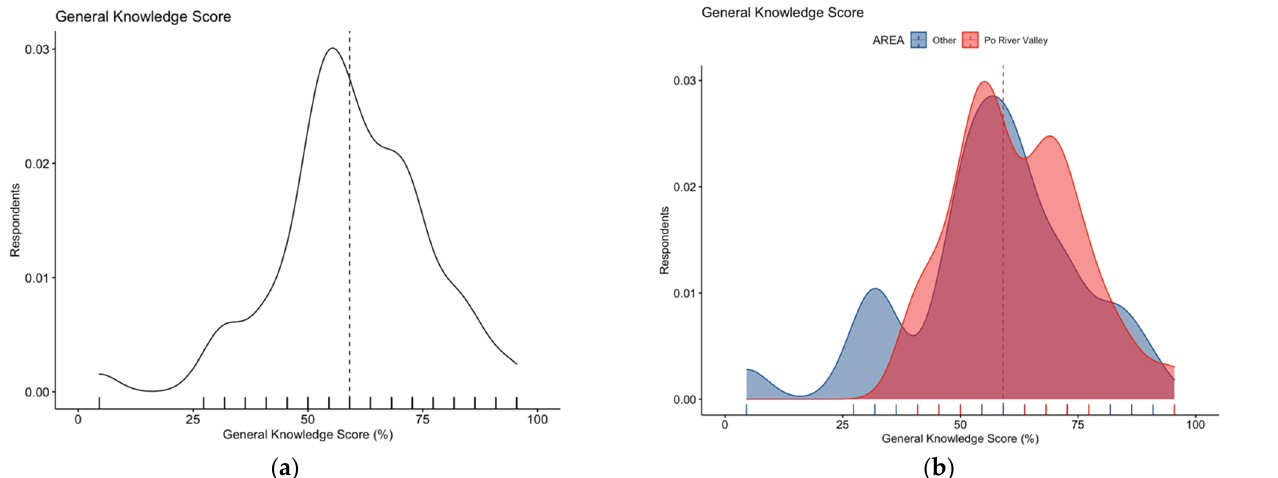
Figure 2. Density plots for: ( a ) general knowledge score in 254 Italian physicians participating into the survey; ( b ) general knowledge score broken down by residence of the respondents. The estimate was substantially skewed (D’Agostino–Pearson’s normality test skewness = − 0.469, z = − 2.993, p -value = 0.003), with higher score for participants residing vs. those not residing in endemic areas (62.2% ± 13.2 vs. 56.7% ± 18.2, Mann–Whitney p value = 0.038). Dotted line represents median values.